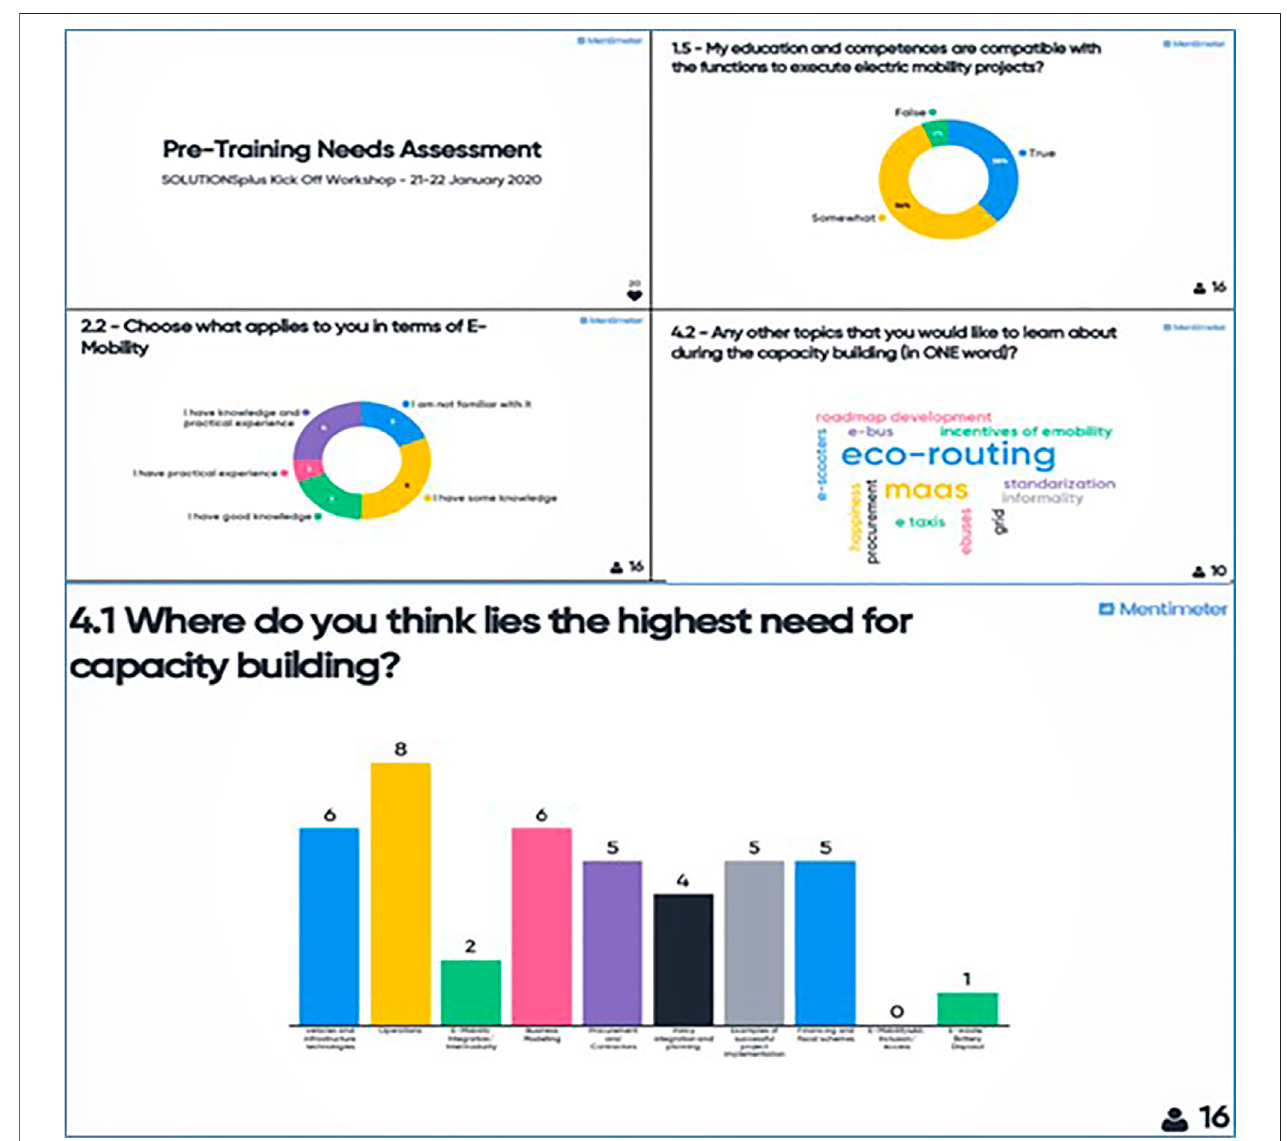
FIGURE 4 | Initial results from the Mentimeter exercise during the project ’ s Kick-Off workshop.